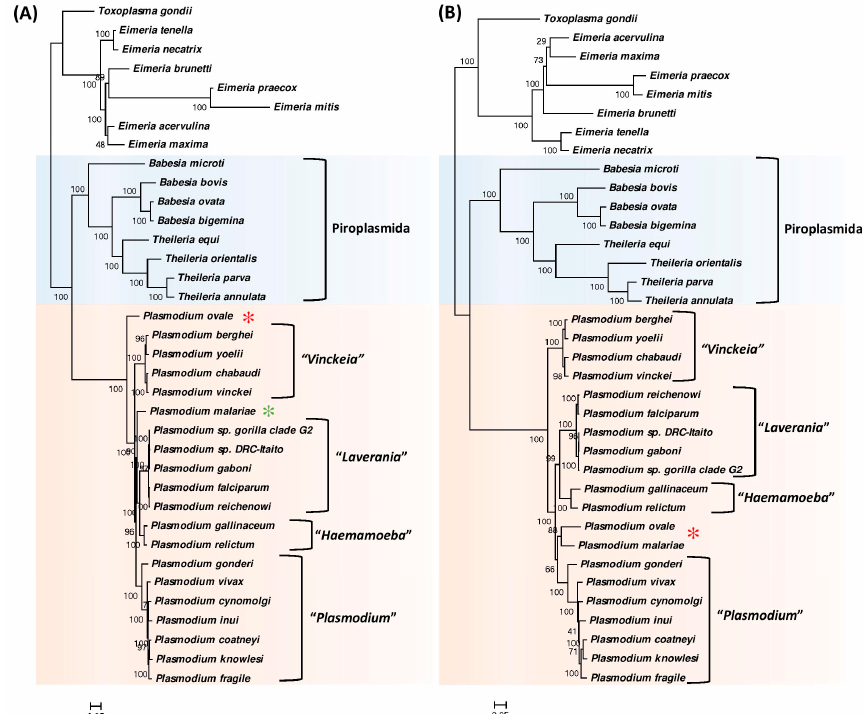
Figure 1. Maximum likelihood trees for the 28 genome sequenced members of the class Hematozoa ( A ) Tree based on concatenated sequence of 14 transcription and translation related proteins and ( B ) tree based on concatenated sequence of 10 conserved metabolism-related proteins. The trees were rooted using sequences from other Apicomplexa species. Numbers on the branches indicate bootstrap values for these nodes. Some of the known taxonomic groups are labelled and the Plasmodium species showing anomalous branching are marked with asterisks (*).